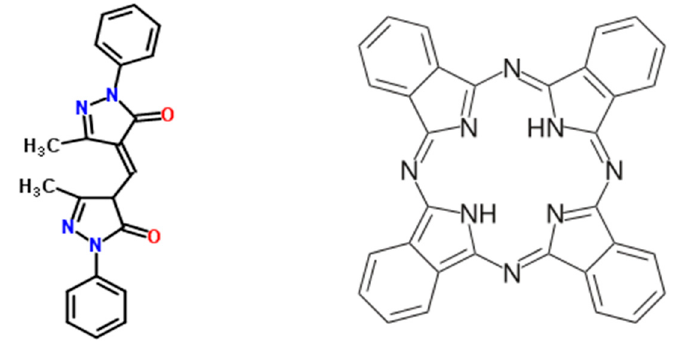
Figure 5. Chemical structure of Solvent Yellow 93 (SY93), which is a pyrazolone-dye ( left ) and